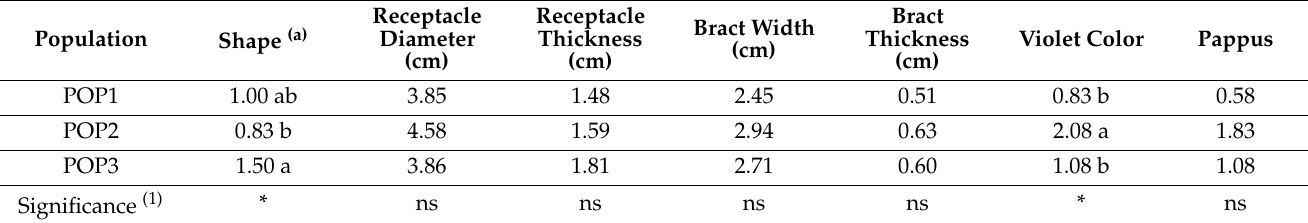
Table 3. Characteristics of the shape, receptacle and bracts of the main flower heads of three popula- tions of ‘Carciofo di Lucera’ (1)